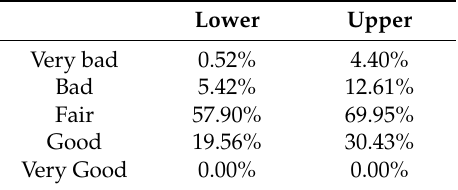
Table 2. Basic services, education, statistical inference.